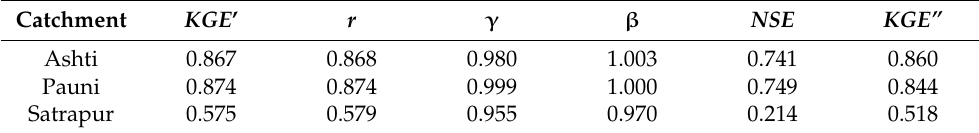
Table 6. Performance metrics (semi-lumped modeling, single parameter